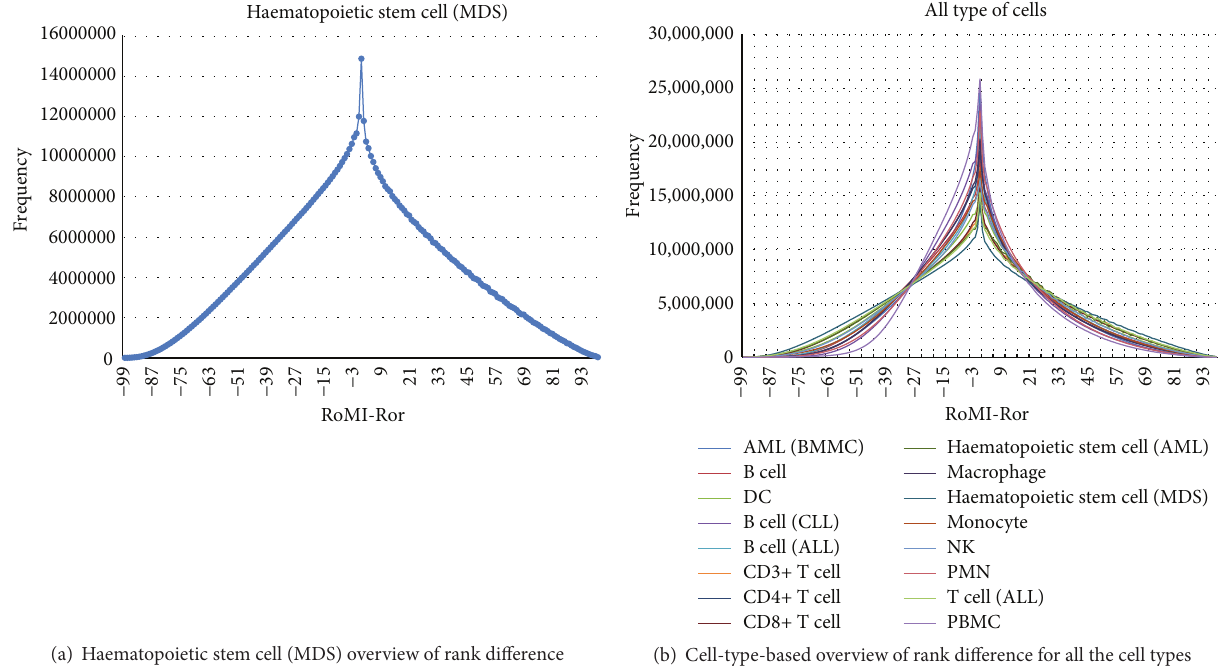
Figure 5: Page for cell-type-based overview of rank